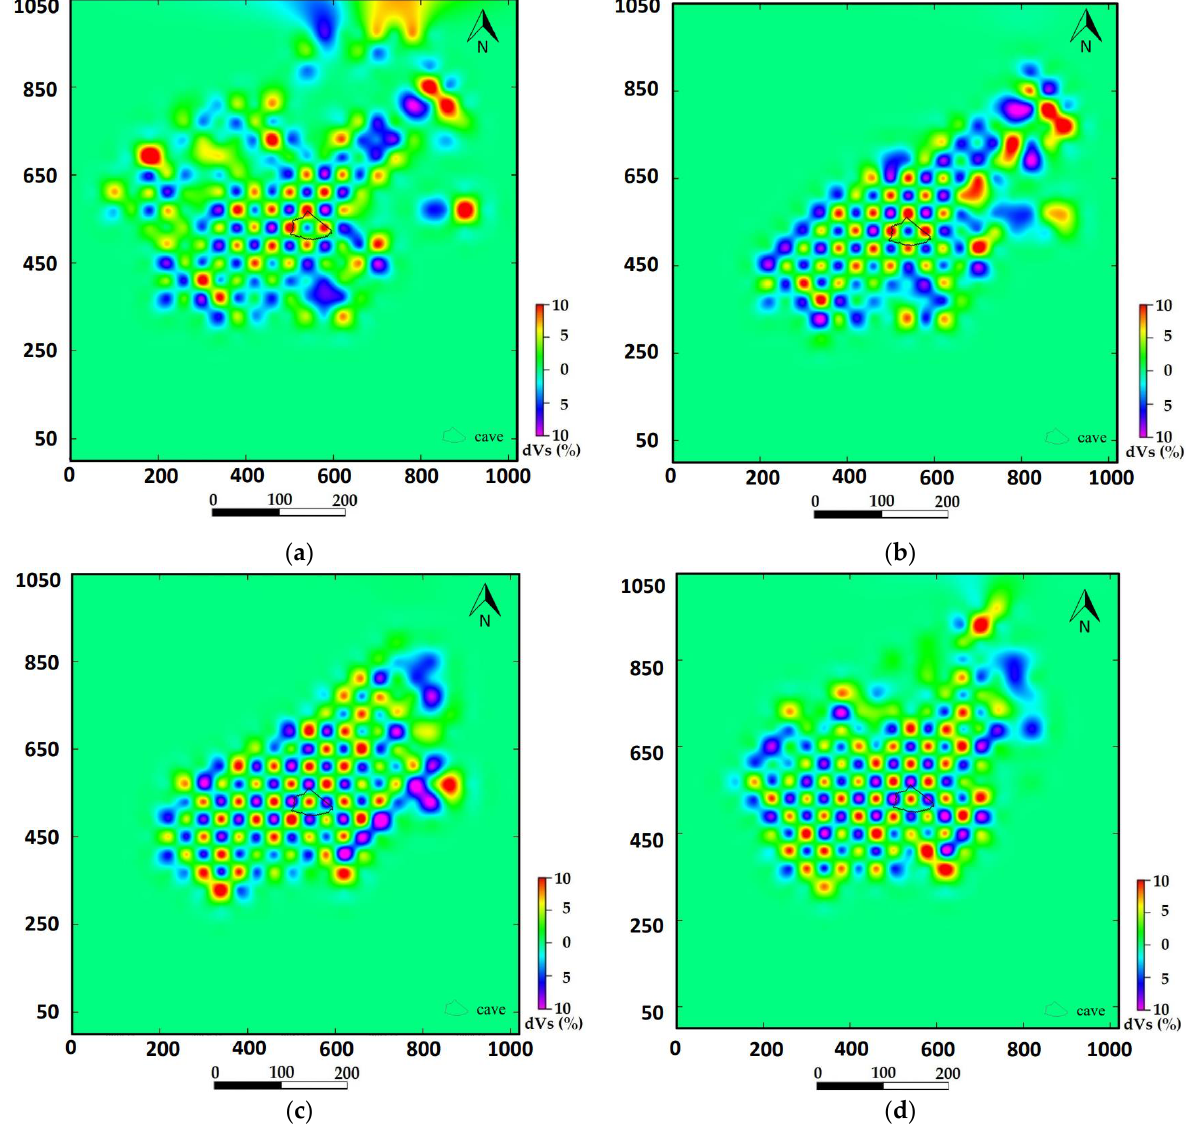
Figure 12. Vs tomogram in the seismogenic zone: ( a ) elevation 1820 msl seismometer scenario following the facility; ( b ) elevation 1820 msl seismometer scenario in the off-facilities area; ( c ) elevation 1780 msl seismometer scenario following the facility; ( d ) elevation 1780 msl seismometer scenario in the off-facilities area.